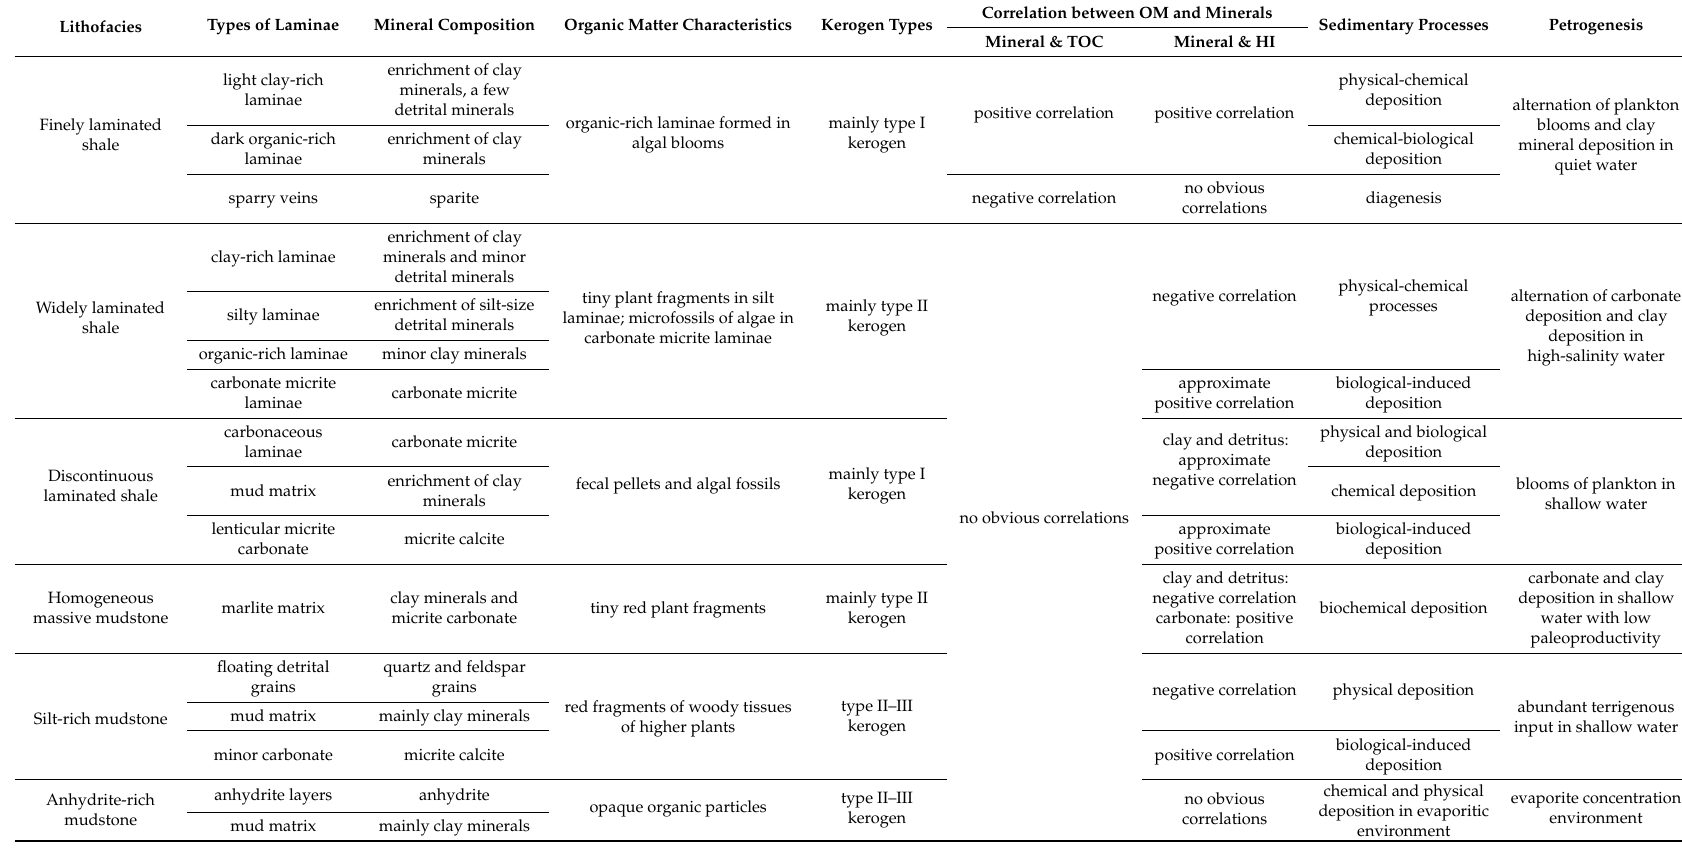
Table 2. Characteristics of lithofacies and their